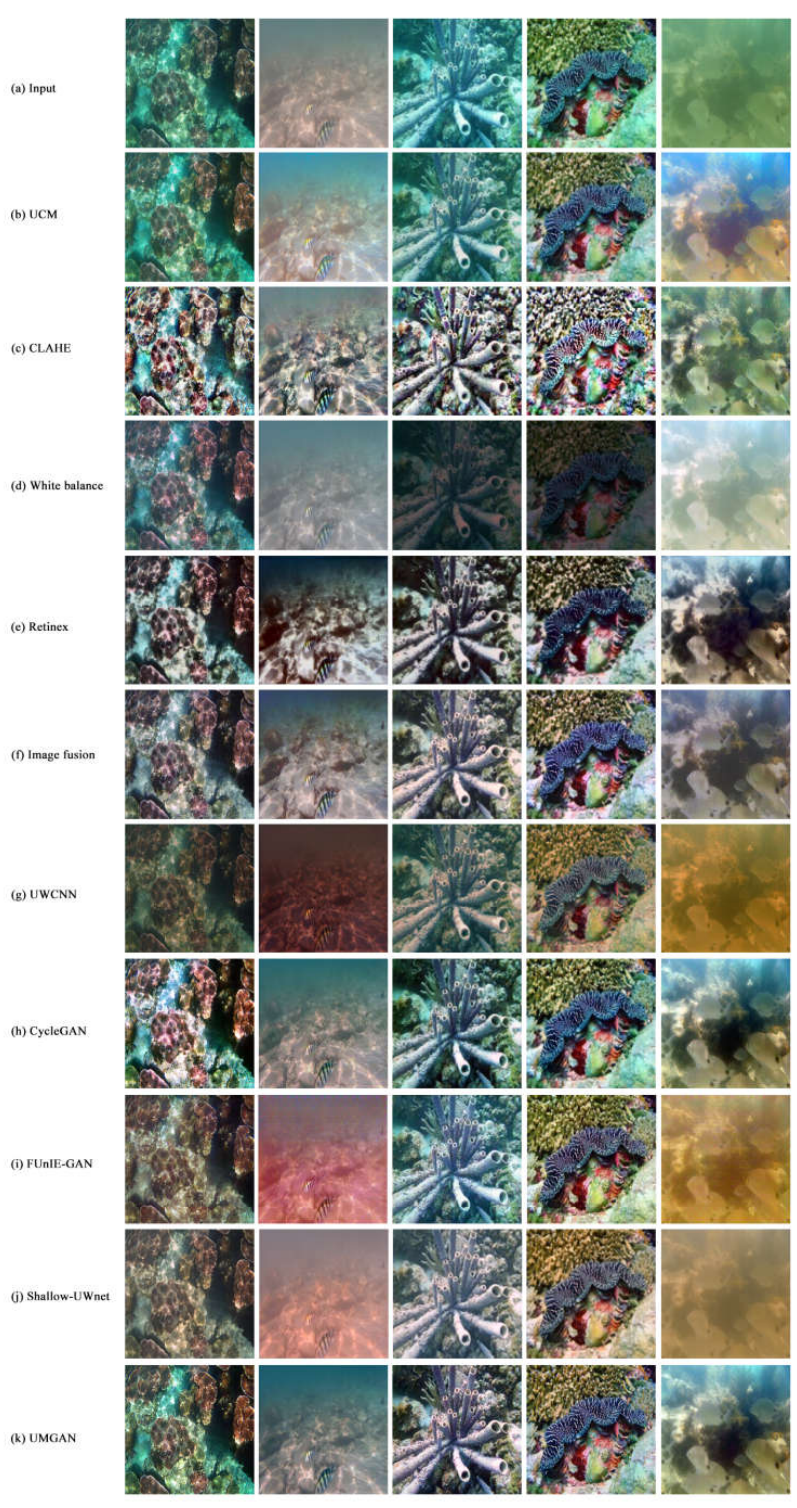
Figure 7. Visual comparison of various underwater image enhancement methods. ( a ) Input images, ( b ) UCM, ( c ) CLAHE, ( d ) White balance, ( e ) Retinex, ( f ) Image fusion, ( g ) UWCNN, ( h ) CycleGAN, ( i ) FUnIE-GAN, ( j ) Shadow-UWnet, ( k ) UMGAN. Columns one to five are greenish, with white haze, blueish, low contrast and yellowish images